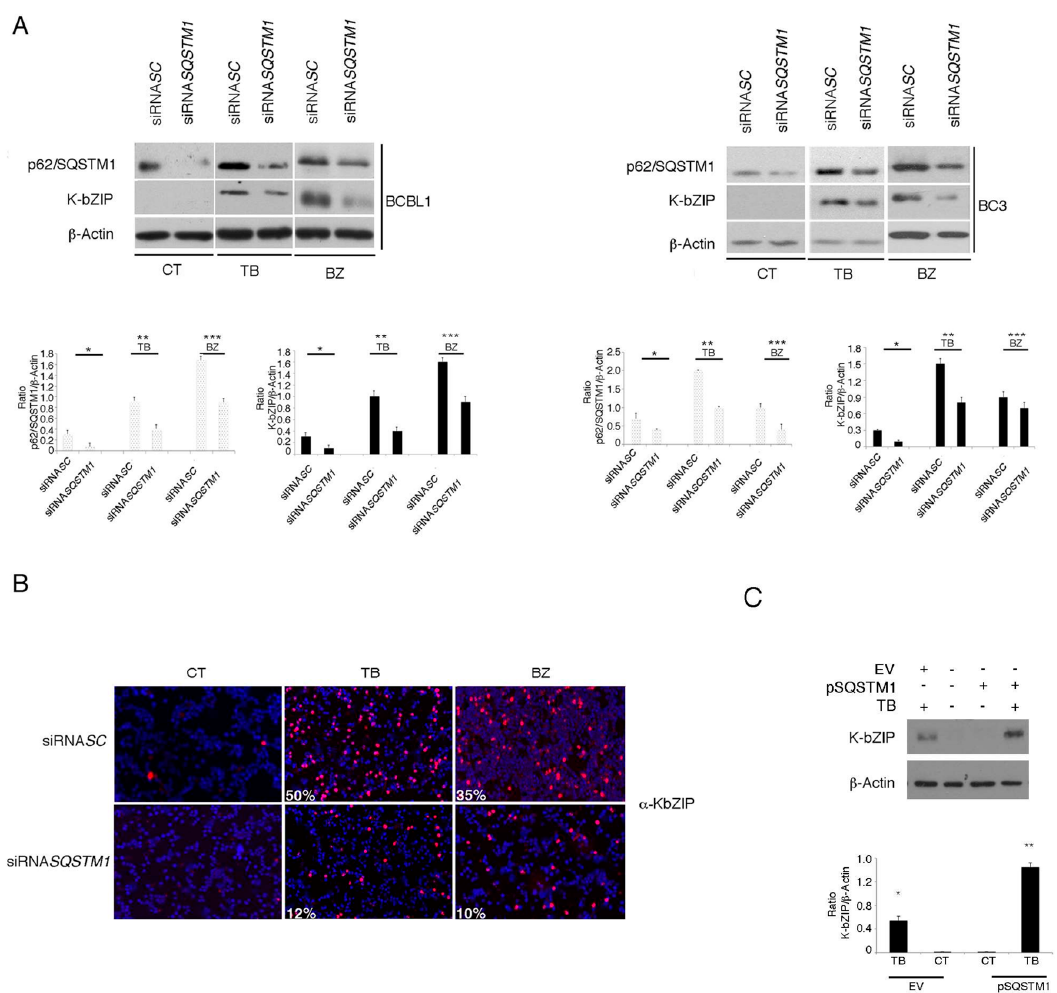
Figure 5. SQSTM1 RNA interference reduces K-bZIP expression in PEL cell lines. ( A ) p62/SQSTM1 expression following RNA interference using a specific siRNA SQSTM1 , before treating PEL cells with TB or BZ. Both p62/SQSTM1 and K-bZIP expression were evaluated by western blotting, and siRNA SC was used as a control. Densitometric analysis was performed using Image J software and the ratio of p62/SQSTM1 and K-bZIP versus β -Actin was calculated. Histograms represent the mean ± standard deviation (SD) of three independent experiments. p * < 0.05 (siRNA SQSTM1 .vs siRNA SC ), p ** < 0.05 (siRNA SQSTM1 vs siRNA SC ; TB-treated) and p *** < 0.05 (siRNA SQSTM1 vs siRNA SC ; BZ-treated) ( B ). K-bZIP expression (red staining) was evaluated by immunofluorescence assay in SQSTM1 knocked-down BCBL1 cells. The percentage of K-bZIP-positive cells is indicated. DAPI was used to stain nuclei (blue). Images are 40× magnification. All results are representative of three independent experiments. ( C ) K-bZIP expression in TB-treated BC3 cells overexpressing SQSTM1, as evaluated by western blot analysis. Densitometric analysis was performed using Image J software and the ratio of p62/SQSTM1 and K-bZIP versus β -Actin was calculated. Histograms represent the mean ±standard deviation (SD) of three independent experiments. p * < 0.05 (TB vs CT; EV- transfection)and p ** < 0.05 (TB vs CT; pSQSTM1-transfection). 3.5. The Main Mediators of Cell Stress Responses, HSF1 and NRF2, Promote P62/SQSTM1 And KSHV Lytic Antigen Expression in TB- or BZ-Treated PEL Cells p62/SQSTM1 is a common transcription target of HSF1 and NRF2, activated during the main mammalian cellular responses to stress (the heat shock and anti-oxidant responses, respectively) [9]. In order to investigate the role HSF1 and NRF2 in p62/SQSTM1 up-regulation and the activation of KSHV lytic antigen expression, we pharmacologically inhibited these transcription factors. In a dose